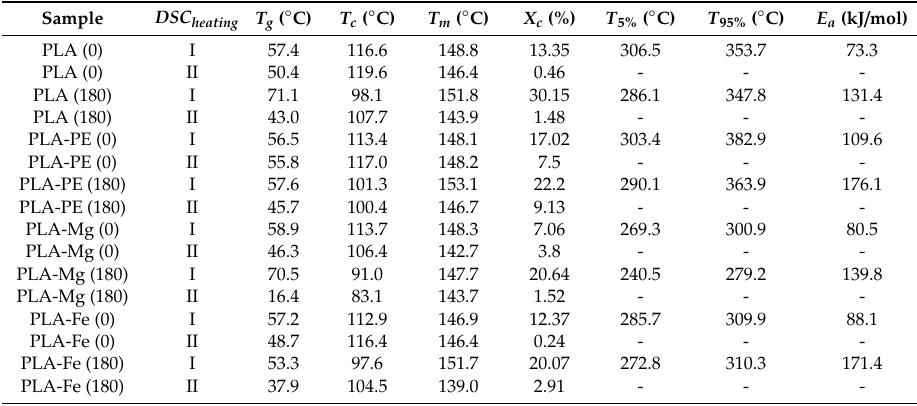
Table 2. Summarized results of DSC analysis: glass transition temperature ( T g ), crystallization temperature ( T c ), melting temperature ( T m ), and crystallinity ( X c ) obtained from DSC curves for first (I) and second (II) heating, and TG analysis: thermal decomposition temperatures for 5% mas . Material loss ( T 5% ) and for 95% mas. material loss ( T 95% ), and activation energy of thermal decomposition ( E a ). Results are presented for control samples (0) and for samples kept in 0.9% NaCl solution for 180 days (180).